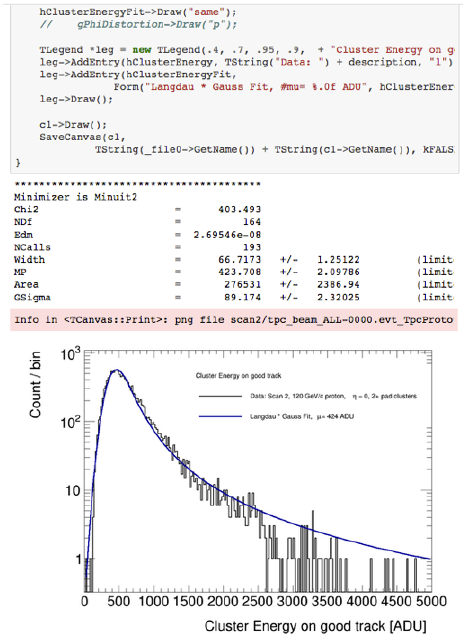
Figure 6. Example sPHENIX ROOT analysis on the SDCC analysis portal (Courtesy J.